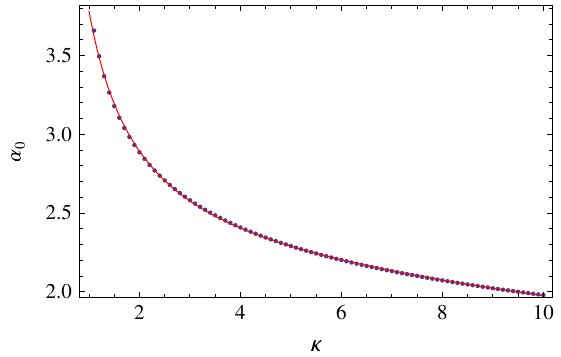
FIG. 10. The initial (cid:7) for the minimum AME emittance. The red curve is given by the approximate expression (cid:7) ¼ (cid:5) =(cid:5) opt max 0 2 : 09 þ 1 : 72 =(cid:12) (cid:1) 0 : 029 (cid:12) . ð (cid:12) Þ ¼ (cid:1) 4 : 49 þ opt